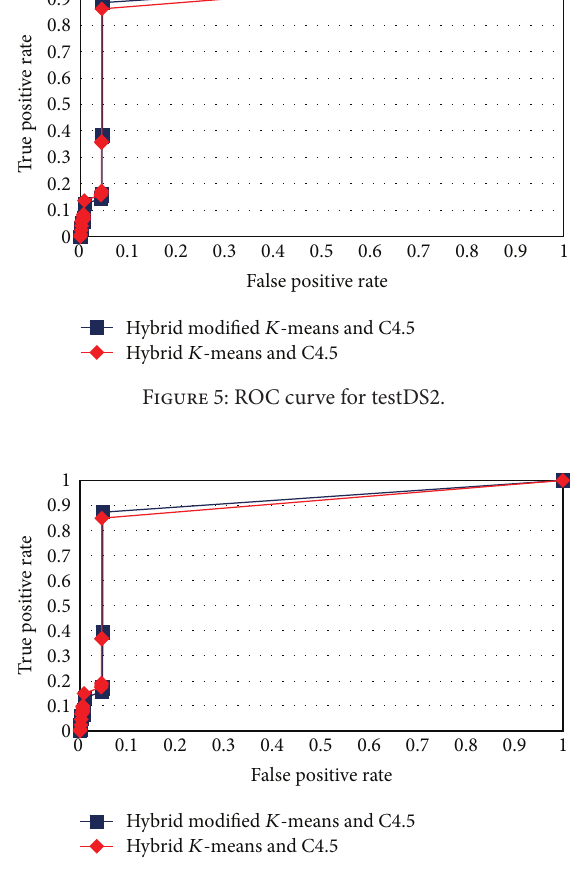
Figure 6: ROC curve for testDS3.